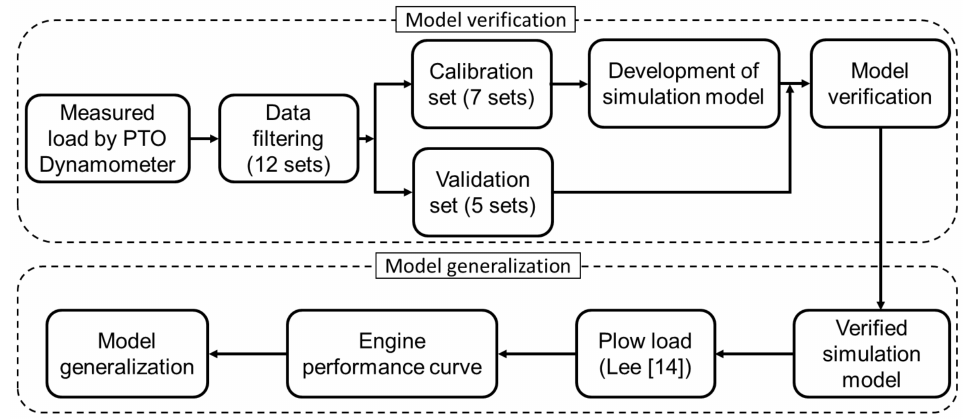
Figure 4. The block diagram of model verification and generalization used in this